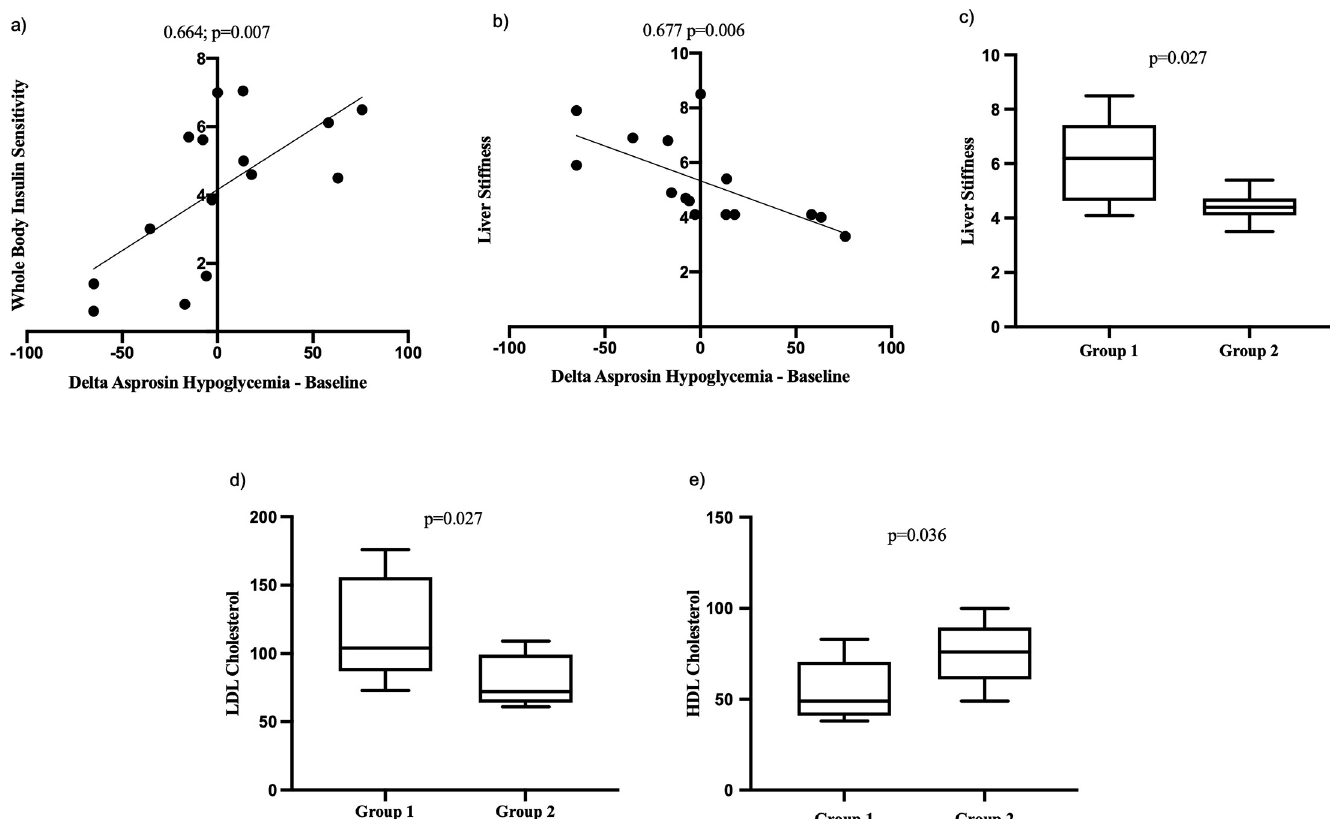
Fig 3. Clinical parameters associated with asprosin increase during hypoglycemia. Group 1 consists of patients without asprosin increase during initial blood glucose lowering or the hypoglycemic phase of the clamp study, group 2 consists of patients with such an increase. (a) shows the correlation between calculated whole-body insulin sensitivity and the calculated delta in asprosin plasma concentrations between the hypoglycemic phase and baseline values. (b) shows the correlation between liver stiffness measured by FibroScan 1 and the calculated delta in asprosin plasma concentrations between the hypoglycemic phase and baseline values. (c) shows the difference in liver stiffness values measured by FibroScan 1 between groups 1 and 2. (d) shows the difference in LDL cholesterol levels between groups 1 and 2. (e) shows the difference in HDL cholesterol levels between groups 1 and 2. Calculated whole-body insulin sensitivity is given in milligrams glucose / kilograms fat-free mass x minute. The delta in asprosin plasma concentrations between the hypoglycemic phase and baseline values is given in nanograms per milliliter. Liver stiffness is given in kilopascals. LDL and HDL cholesterol are given in milligrams per deciliters. LDL = low-density lipoprotein. HDL = high-density lipoprotein. With correlations, spearman correlation coefficient is